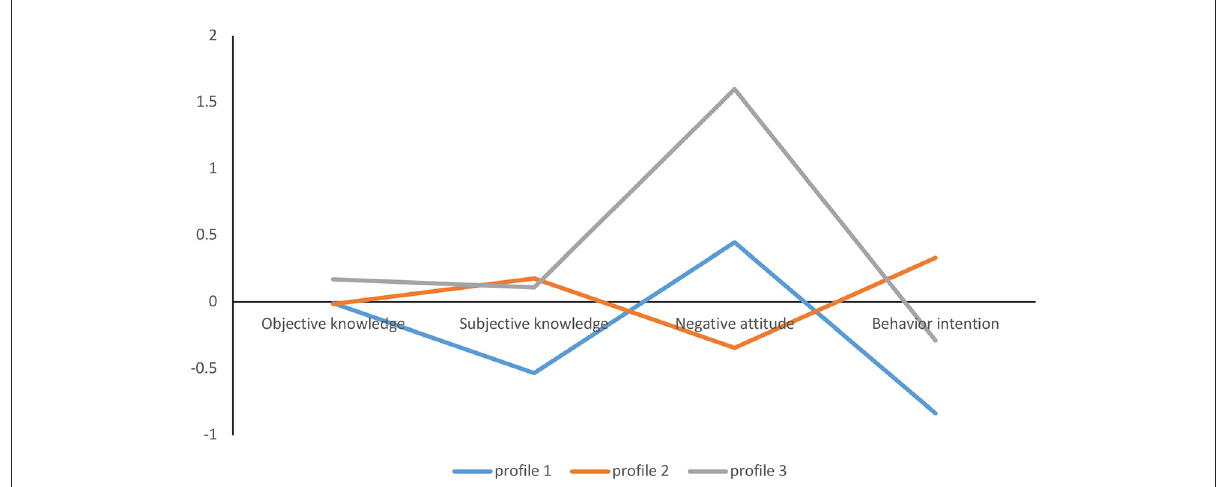
FIGURE4 Latent profiles KAB profiles of medical AI. The y-axis refers to the mean Z score of the participants’ objective knowledge, subjective knowledge, negative attitudes, and behavioral intentions.